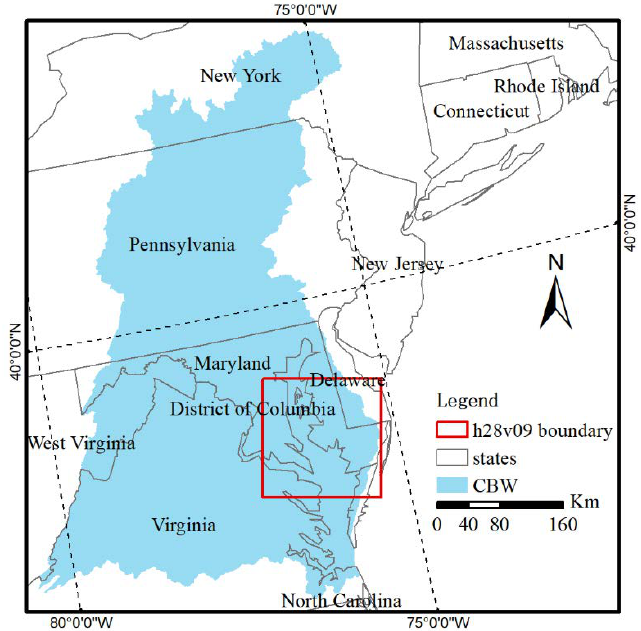
Figure 1. Location of study area (h28v09) in Chesapeake Bay Watershed